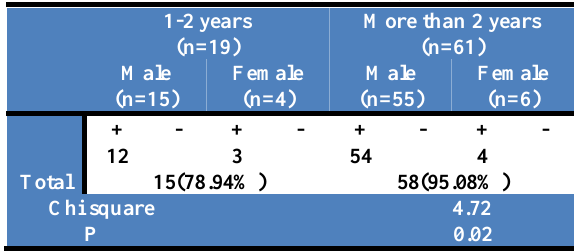
Table, 2: Number of positive isolates for E.coli O157:H7 in feces samples of cattle according to the age and geneder.